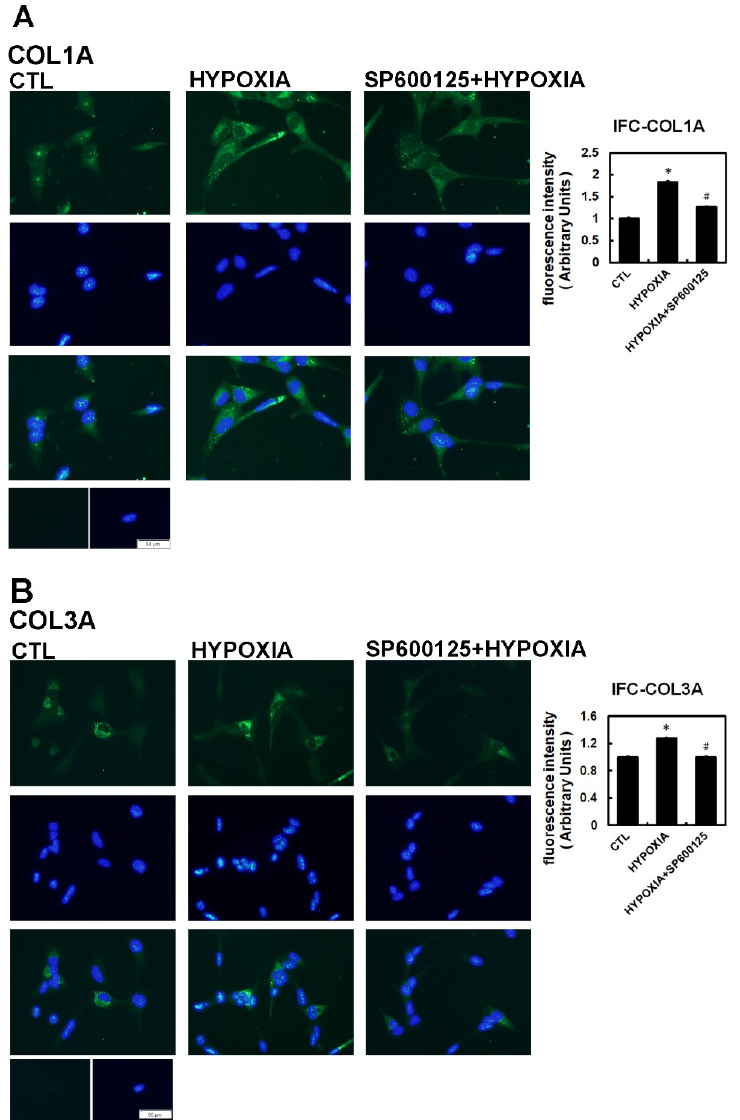
Figure 4. Immunohistochemistry assay of hypoxia-treated HL-1 cells. The HL-1 cells were pre-treated with inhibitors SP600125 (10 − 5 M) or DMSO as a vehicle for 30 min, treated with hypoxia stress (1% O 2 ) for 6 h, fixed and subjected to immunostaining with anti-COL1A (Panel A ) and anti-COL3A antibody (Panel B ). Quantification of the number of pixels with intracellular label was determined digitally from the fluorescence microscopic images. All indicated fibrotic marker protein densities were significantly reduced in all the cells pre-treated with SP600125 compared to those treated by hypoxia only. Values are the arithmetic means of at least three independent experiments and change to the numbers of pixels are expressed as percent increase or decrease compared to the control level (DMSO only). The percentage of fluorescing cells was calculated per condition as described in Methods. The scale bar corresponds to 50 µ M. The data are mean ± SEM ( n > 100, * p < 0.01 vs. control; # p < 0.05 vs. hypoxia).